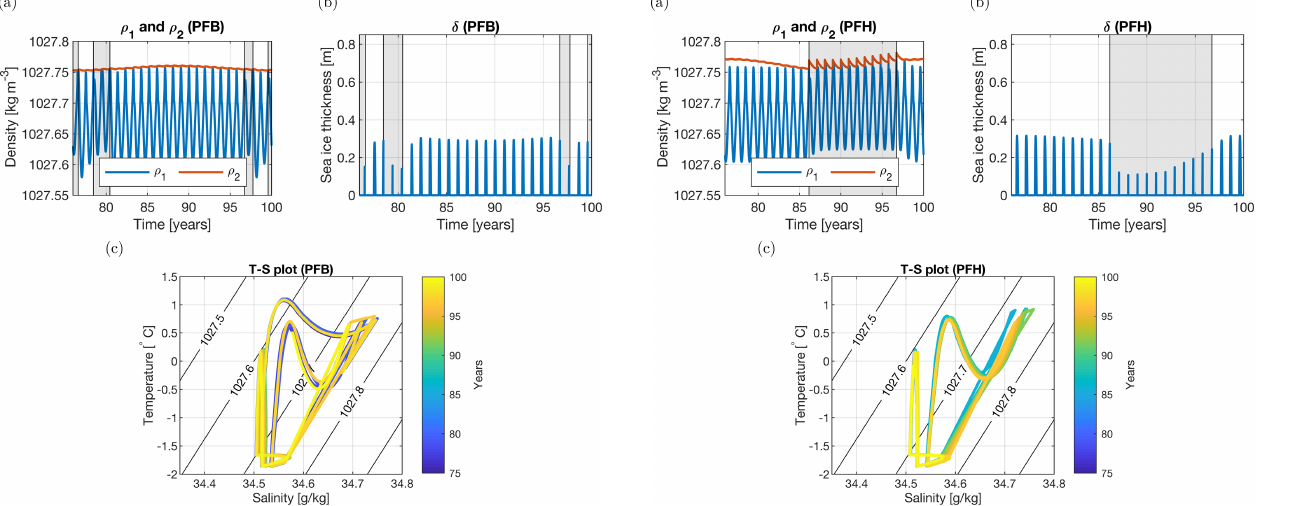
Figure 9. Years 76–100 for the PFH case (with only a subsurface heat flux). (a) Density of the surface (blue) and subsurface (red) layer. (b) Sea-ice thickness. The shading in panels (a) and (b) rep- resents polynya years. (c) T – S plot of the temperature and salin- ity of the surface layer. The coloring of the lines represents time, ranging from year 76 (blue) to year 100 (yellow). The black con- tour lines represent the density (in kgm − 3 ). Polynyas are present between year 86 (cyan) and year 96 (orange).